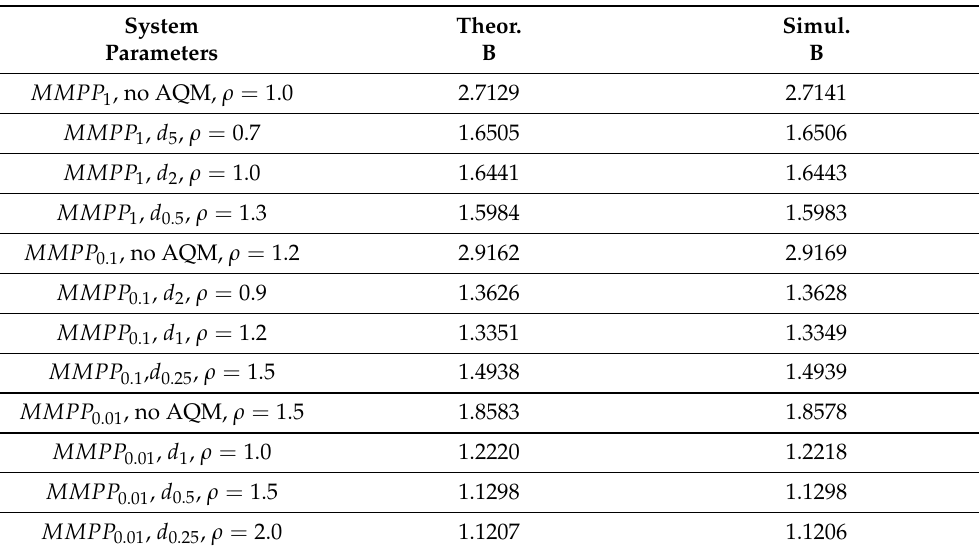
Table 1. Theoretical vs. simulated burst ratio for different system parameters (arrival process, drop probabilities, and link load). System Theor. Simul. Parameters B B MMPP 1 , no AQM, ρ = 1.0 2.7129